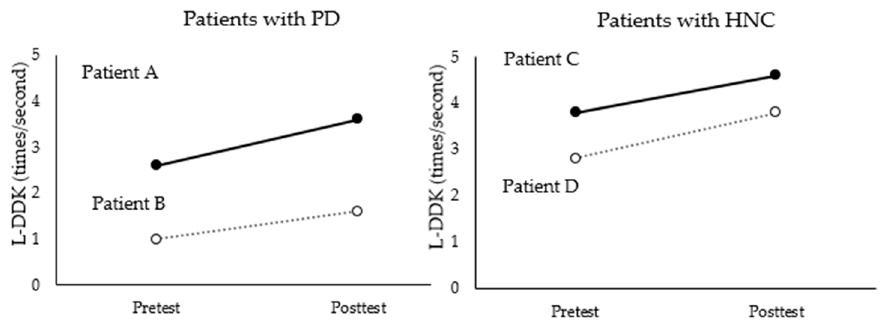
Figure 2. Results of L-DDK measurement before and after the intervention for each patient.